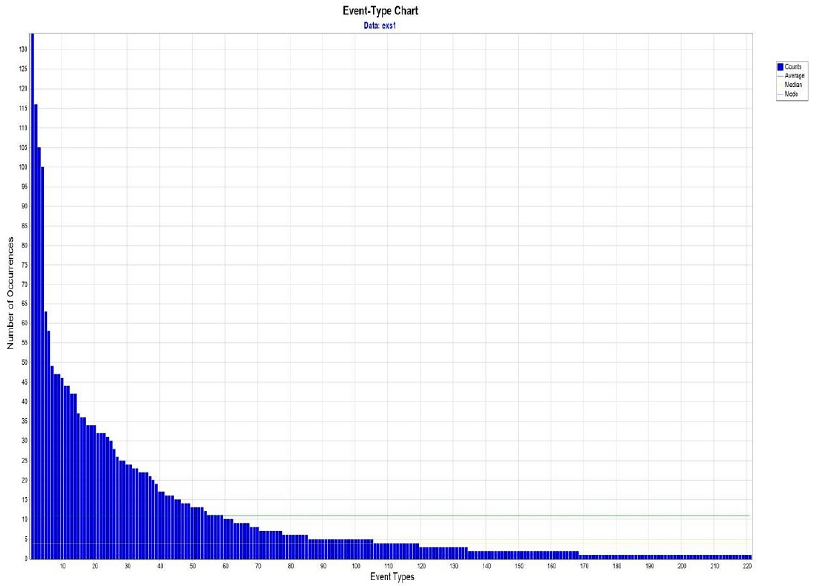
Figure 3. Distribution of event type during the first session.